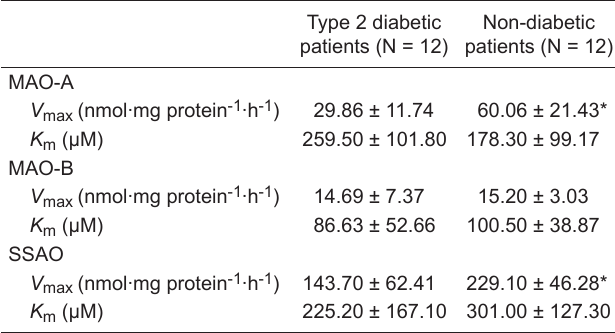
Table 1. Kinetic parameters of MAO-A, MAO-B and SSAO ( V max and K m ) in mesenteric artery homogenates from patients with type 2 diabe- tes and from non-diabetic